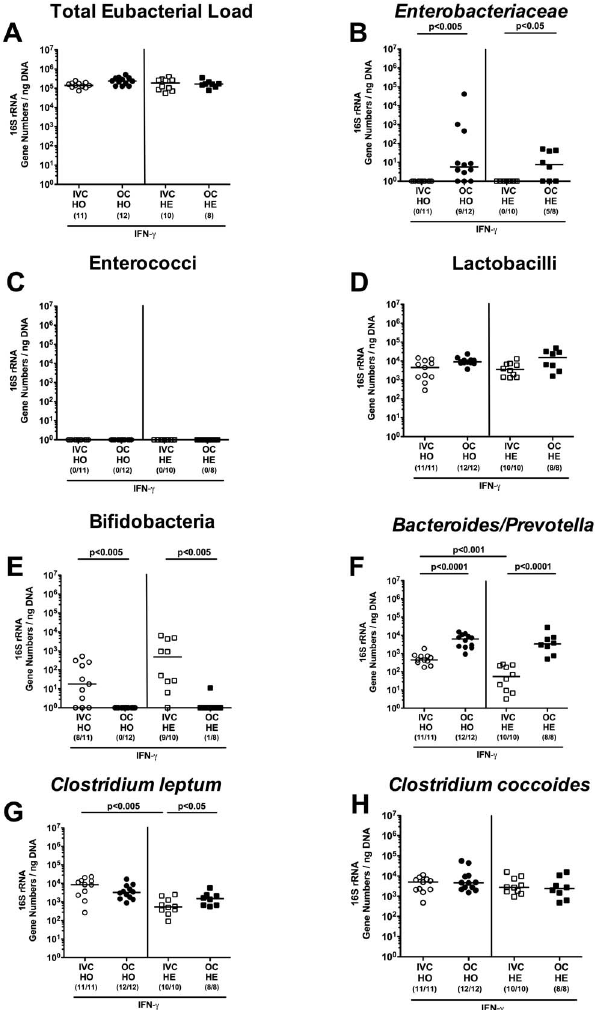
Figure 6. Commensal intestinal microbiota composition of IFN- c deficient mice kept in IVC or open cages. After eight weeks housing of homozygous (HO; circles) or heterozygous (HE; squares) IFN- c gene-deficient mice in IVC (white symbols) or open cages (OC; black symbols), 16S rRNA of main intestinal bacterial groups was quantified in individual fecal samples. ( A ) Total eubacterial loads and quantitative abundance of ( B ) Enterobacteriaceae , ( C ) enterococci, ( D ) lactobacilli, ( E ) bifidobacteria, ( F ) Bacteroides/Prevotella spp., ( G ) Clostridium leptum group, and ( H ) Clostridium coccoides group are expressed in gene numbers per ng DNA. Medians (black bars), levels of significance ( P - values) determined by the Mann-Whitney-U test and numbers of analyzed animals (in parentheses) are indicated.